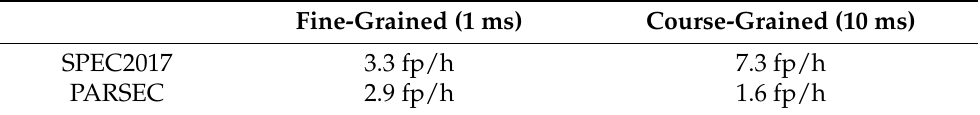
Table 4. False-positive rate caused by